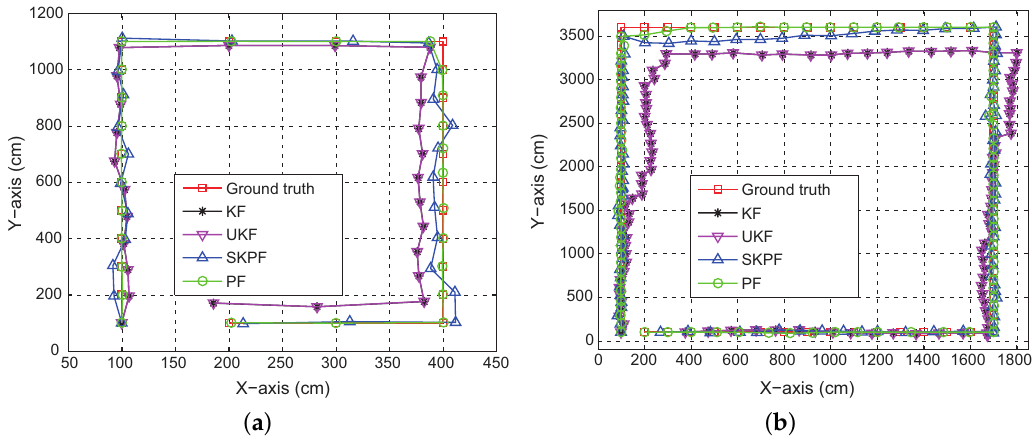
Figure 13. User trajectory estimated using localization algorithms when the user walks along physical locations marked with a sequence number in: ( a ) Scenario S1; and ( b ) Scenario